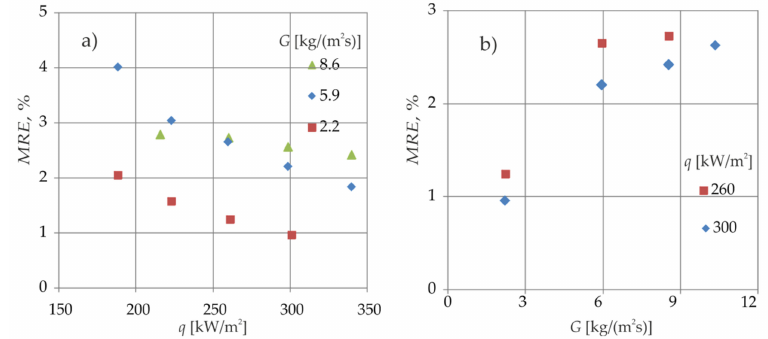
Figure 15. Mean relative error vs. ( a ) heat flux q , and ( b ) mass